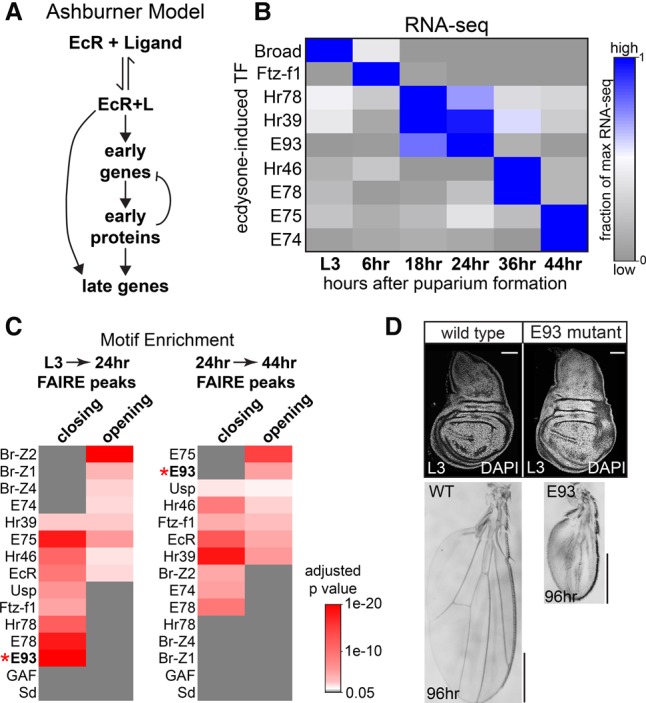
A temporal cascade of ecdysone-induced transcription factors in pupal wings. (A) Diagram of the Ashburner model of ecdysone signaling. (B) Heat map of gene expression values for selected ecdysone-induced genes across six stages of wing development, plotted as a fraction of the maximum expression value. Blue shows high expression, and gray shows low expression. (C) Heat maps of DNA-binding site motif enrichment in dynamic FAIRE peaks for selected transcription factors. (D) DAPI stain of L3 wing discs (top) and bright-field images of 96- h wings (bottom) from wild-type (left) and E93 mutants (right). Bars: top, 75 µm; bottom, 500 µm.